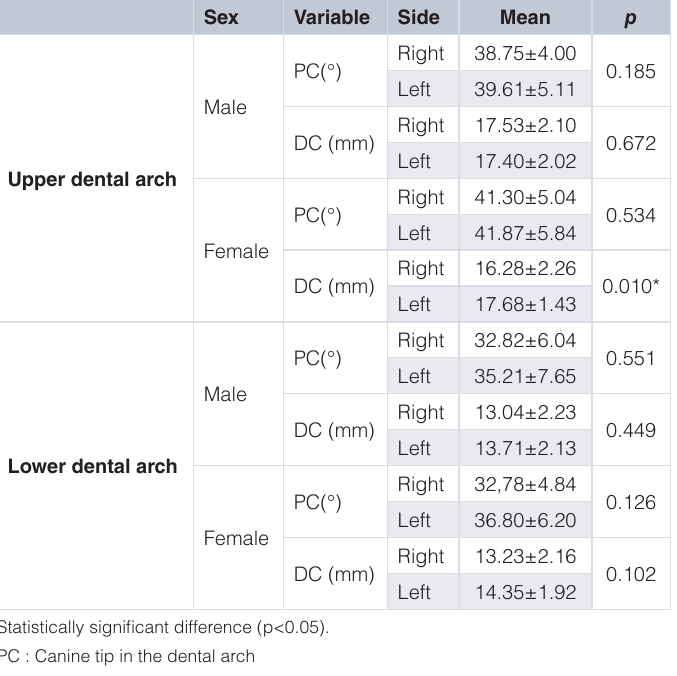
Table 3. Difference of symmetry variables of upper and lower dental arch based on gender.